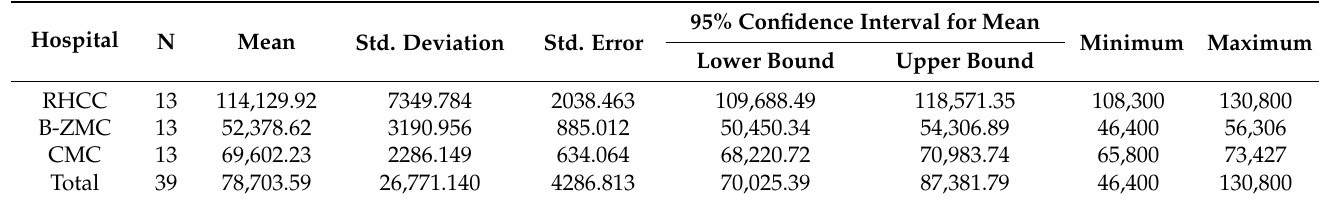
Table 1. Descriptive data on number of visits to three hospitals’ emergency departments (R, RHCC; B, B-ZMC; C, CMC). N = number of year quarters measured.